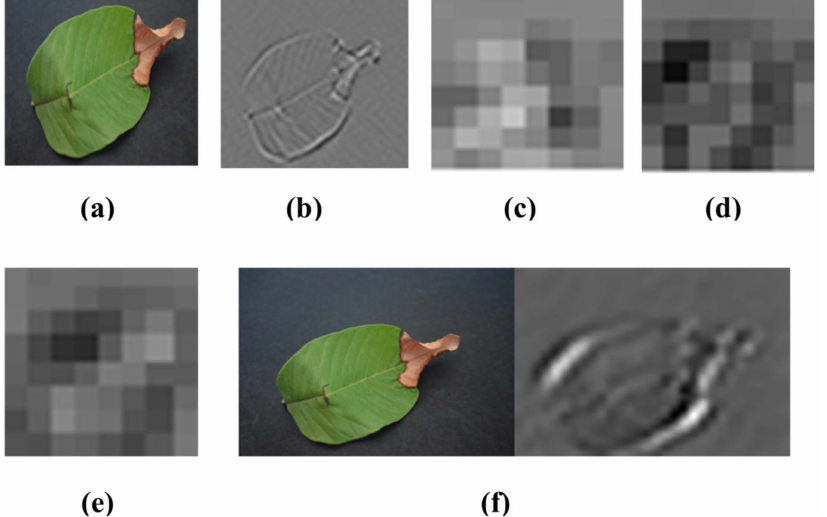
Figure 6. Visualization of the images of strong feature maps of different convolution layers of AlexNet. ( a ) conv2 ( b ) conv1 ( c ) conv3 ( d ) conv4 ( e ) conv5 ( f ) conv6.